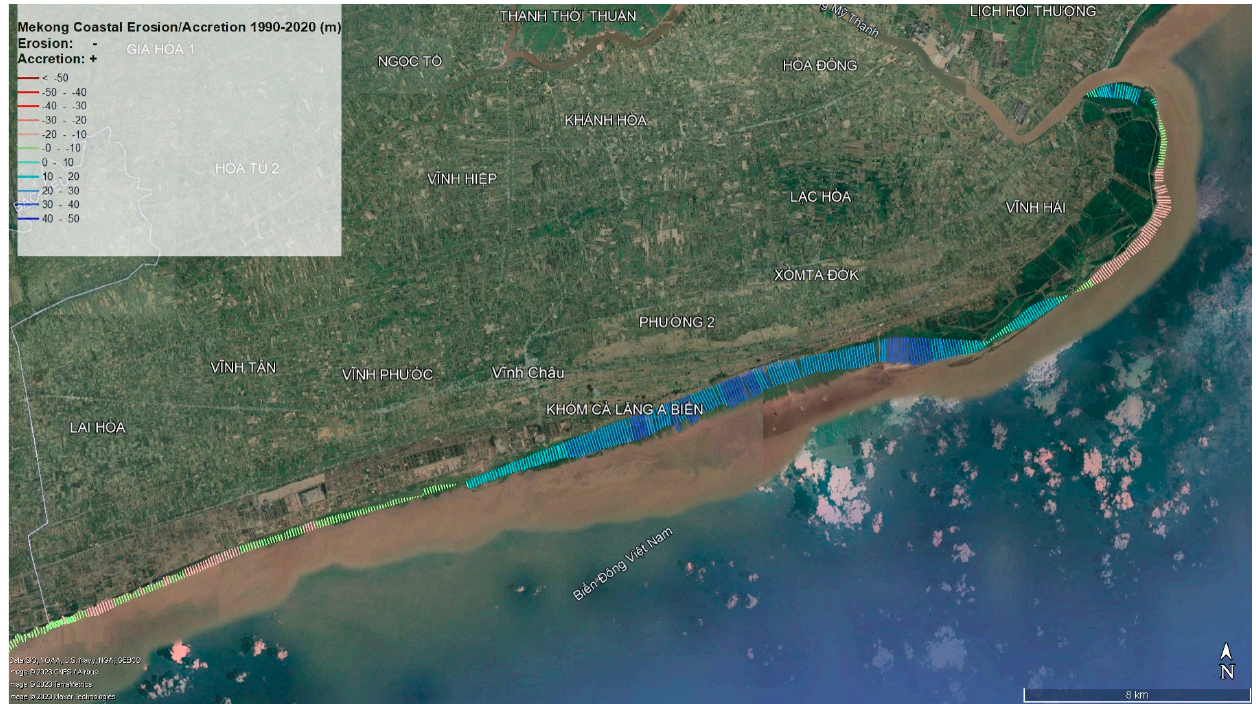
Figure 1. Coastal zone satellite image processing of Soc Trang province from 1980 to 2018 (Google